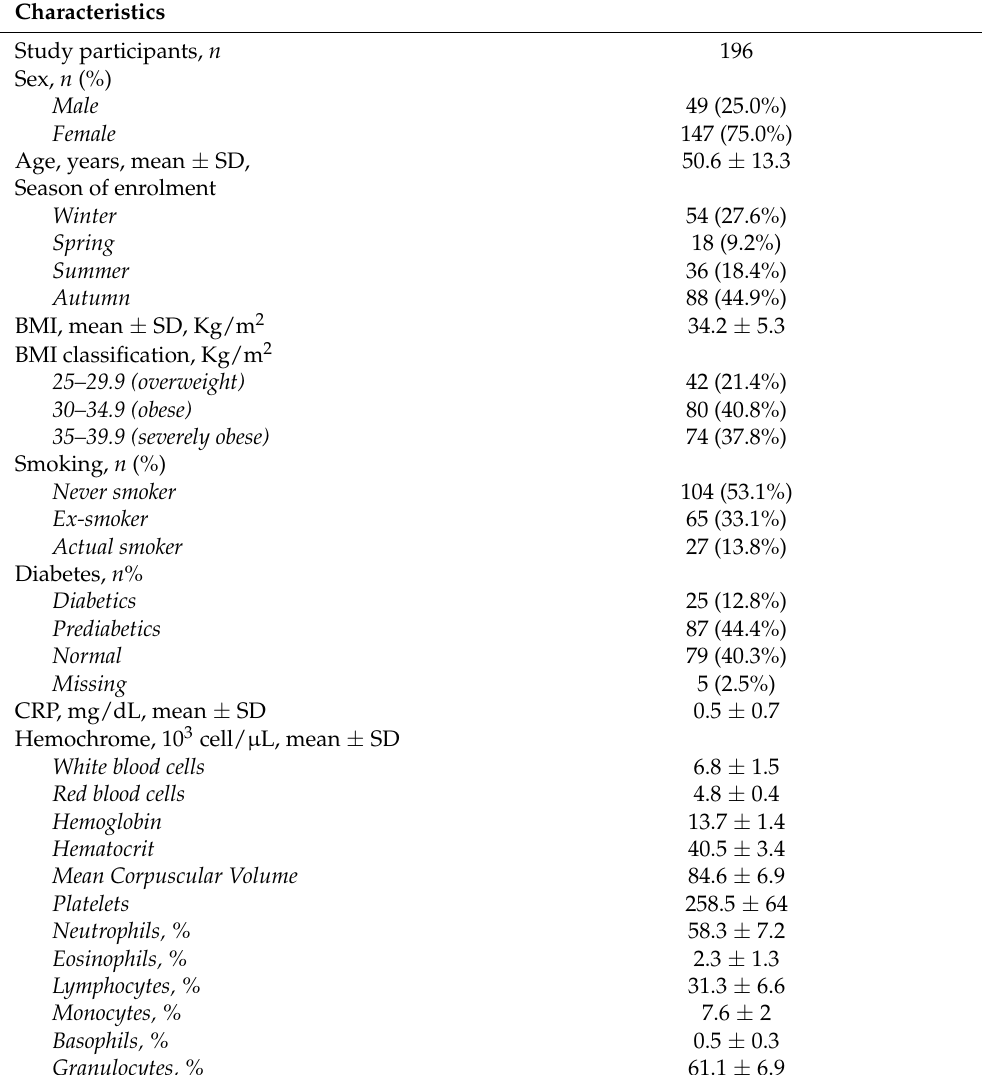
Table 1. Characteristics of study